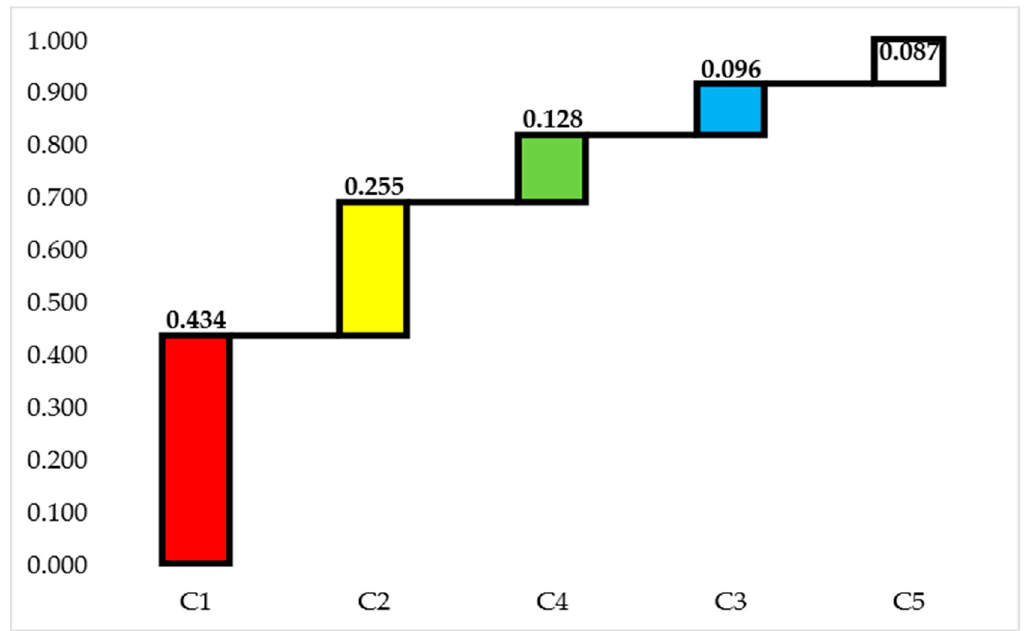
Figure 2. Results of applying the FUCOM method – criterion weights.